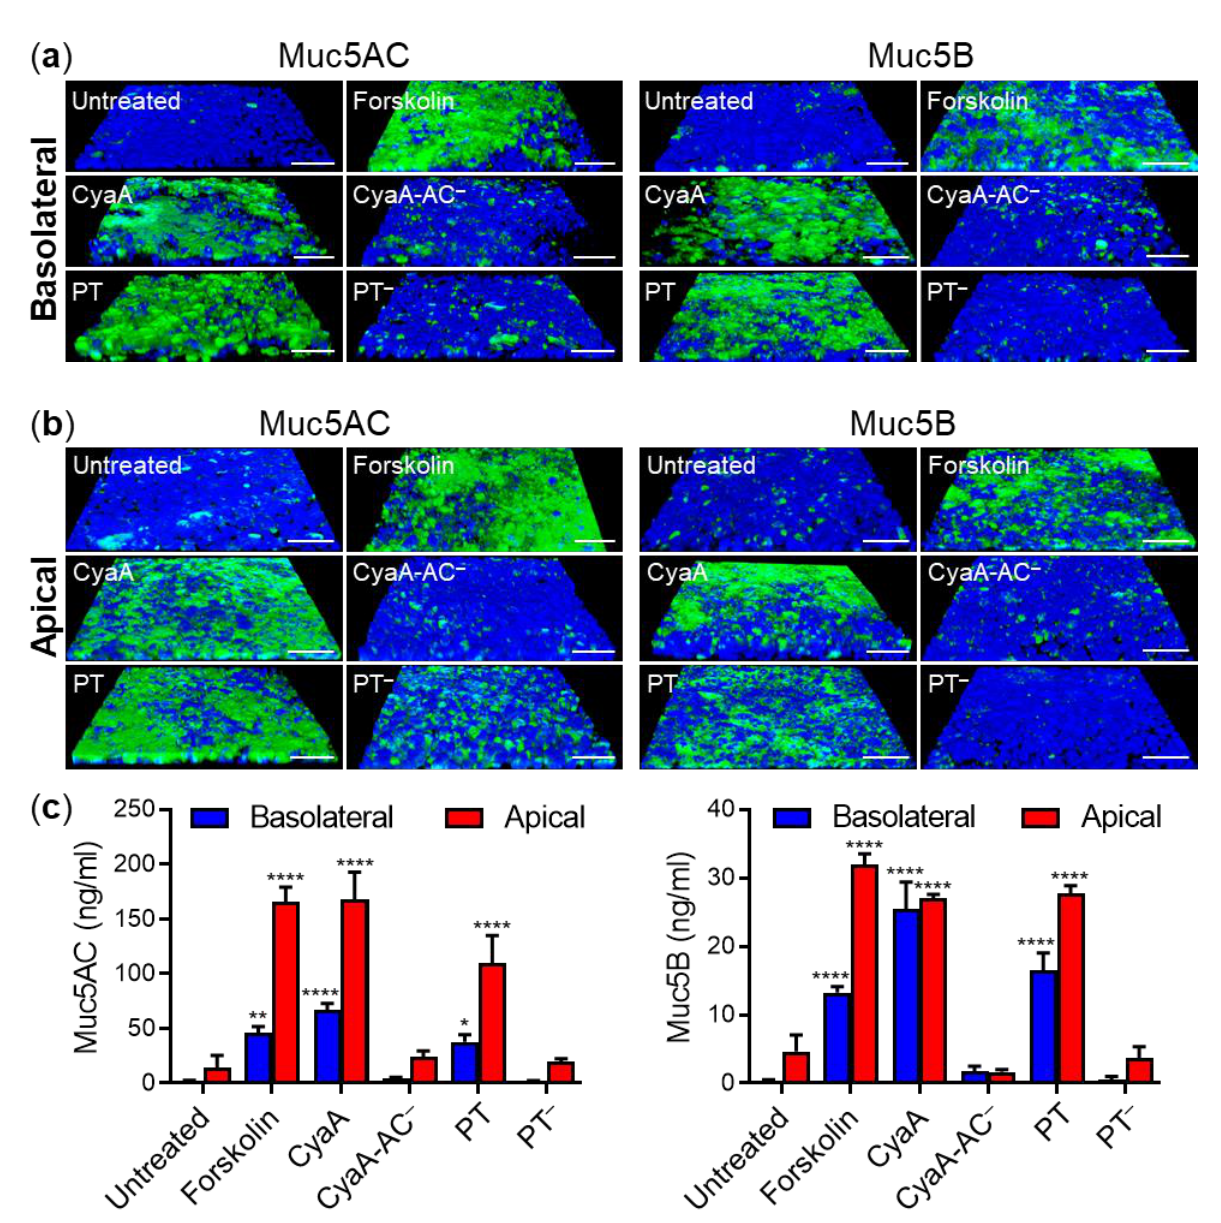
Figure 1. Purified CyaA and PT stimulate production of Muc5AC and Muc5B by polarized ALI-grown bronchial epithelial cells. Bronchial VA10 cell layers were treated from the basolateral ( a ) or the apical ( b ) side with 100 ng/mL of CyaA, CyaA-AC – , PT, PT – or 20 µ g/mL of forskolin for 24 h at 37 ◦ C. The layers were fixed with 4% PFA, immunofluorescently labeled for Muc5AC and Muc5B (green) and analyzed by confocal microscopy. Cell nuclei were stained with DAPI (blue). Images of Muc5AC and Muc5B staining representative of at least three independent experiments are shown. Scale bars correspond to 50 µ m on x-axis at the front edge. ( c ) The amounts of Muc5AC and Muc5B secreted onto the apical cell layers were quantified by ELISA in washes of cell layers. Bars represent means with SEM of detected Muc5AC and Muc5B amounts from at least three independent experiments. *, p < 0.05; **, p < 0.01; ****, p < 0.0001 compared with untreated cell layers.